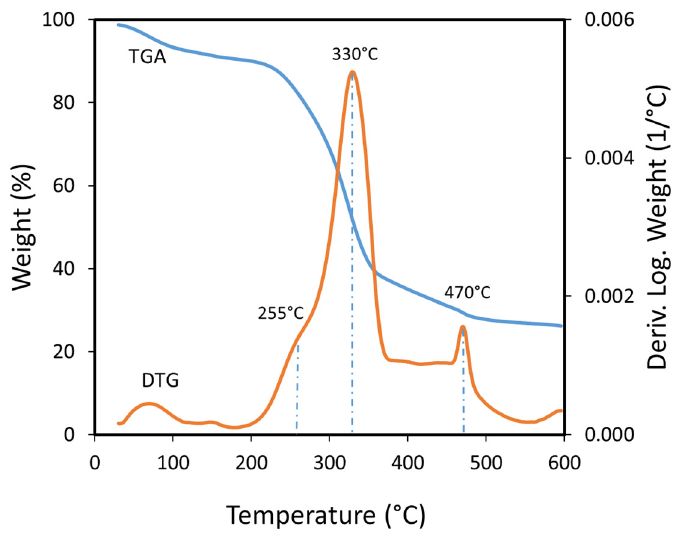
Figure 3. TGA and DTG curves obtained from Agave salmiana bagasse thermal decomposition.